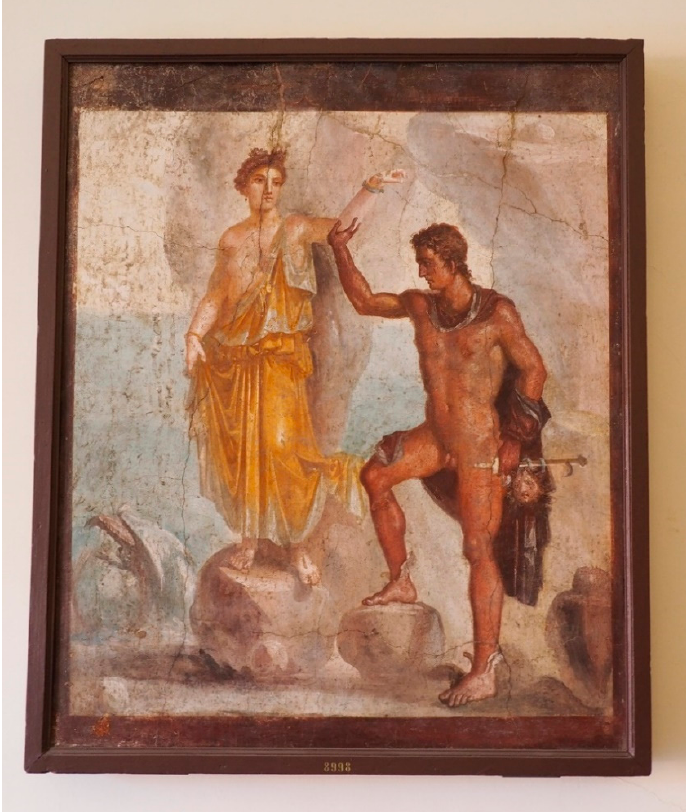
Figure 2. Mythological picture from the peristyle of the Casa dei Dioscuri (Pompei) with Perseus and Andromeda, fourth style, Naples, Museo Archeologico Nazionale 8998; © Author.